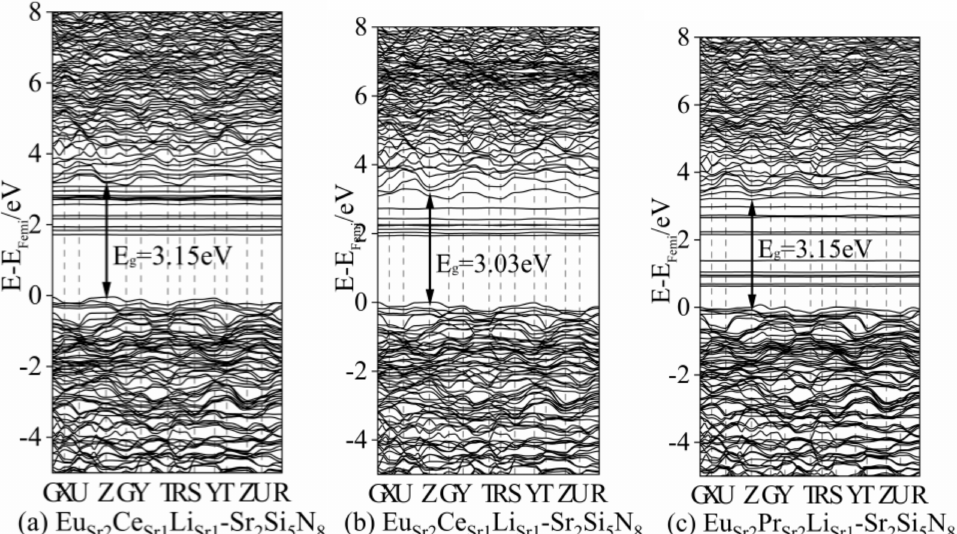
Figure 7. Band structures of doped structures: ( a ) Eu Sr1 Ce Sr1 Li Sr1 -Sr 2 Si 5 N 8 ; ( b ) Eu Sr2 Ce Sr1 Li Sr1